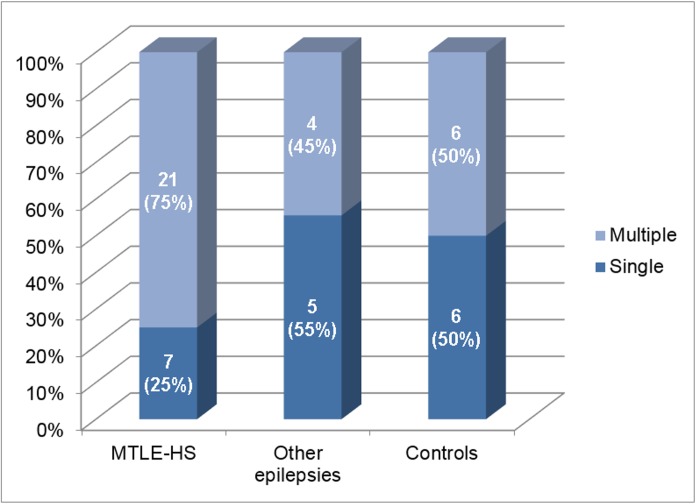
Number of neurocisticercotic calcifications in each group.This graph shows the percentage of subjects with single or multiple calcifications in each subgroup (MTLE-HS, other epilepsies, disease controls). There were no significant group differences regarding the load of lesions (p = 0.14). MTLE-HS = Mesial temporal lobe epilepsy with hippocampal sclerosis.